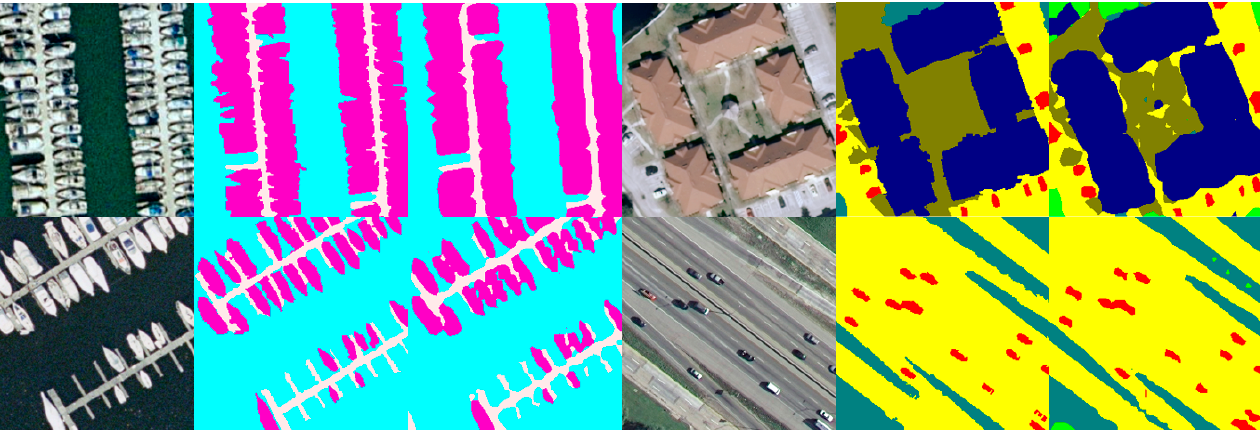
Figure 7. Examples of semantic segmentation results from the DLRSD, (from left to right are: the original image, the ground truth, and the predicted image).